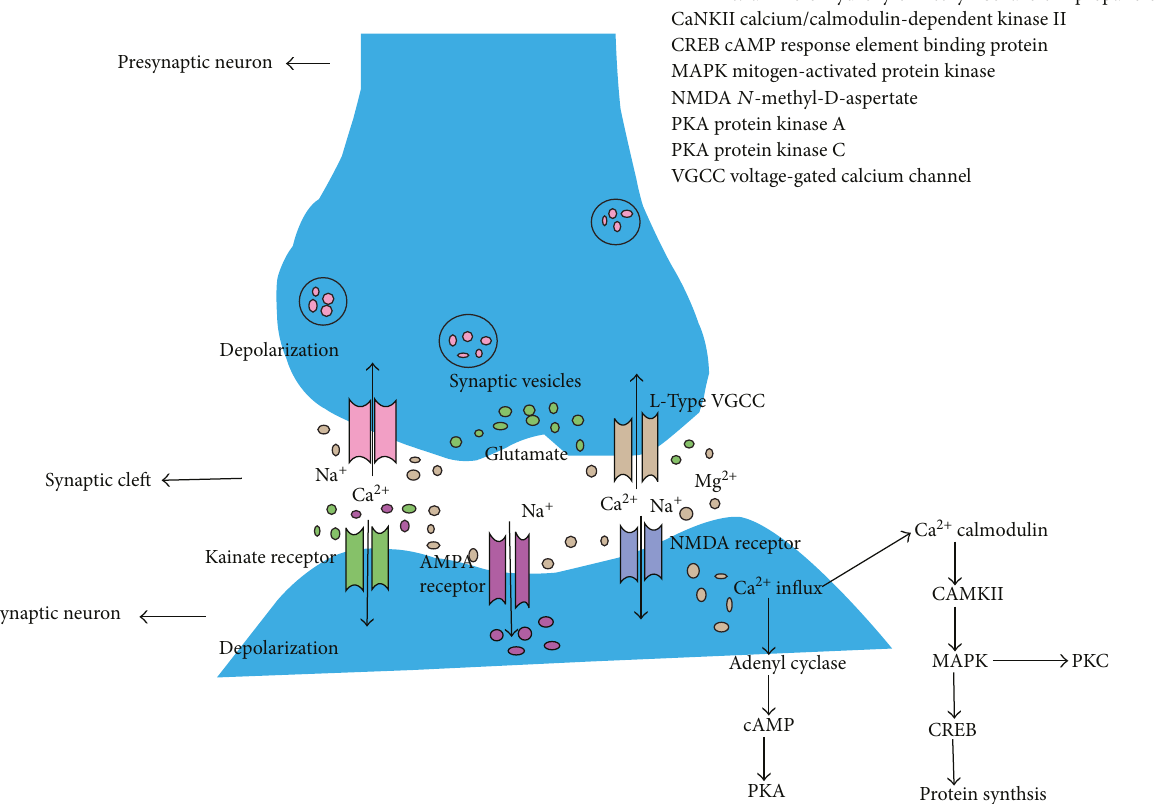
Figure 1: Transmission of signals through the synaptic junctions. Signals or impulses at the presynaptic terminal trigger the release of glutamate that binds to glutamate receptors at the postsynaptic membrane. Activation of α -amino-3-hydroxy-5-methyl-isoxazole-4- propanoic acid (AMPA) as well as kainate receptors which subsequently transport sodium ions that trigger postsynaptic depolarization. As membrane potential changes, it initiates the release of magnesium ions which blocks N -methyl-D-aspartate (NMDA) receptors. In fl ux of calcium via NMDA channels sets o ff a chain of events which establish long-term potentiation. Kainate receptors at the presynaptic end also seem to facilitate synaptic transmission at particular synapses by accumulating neurotransmitter